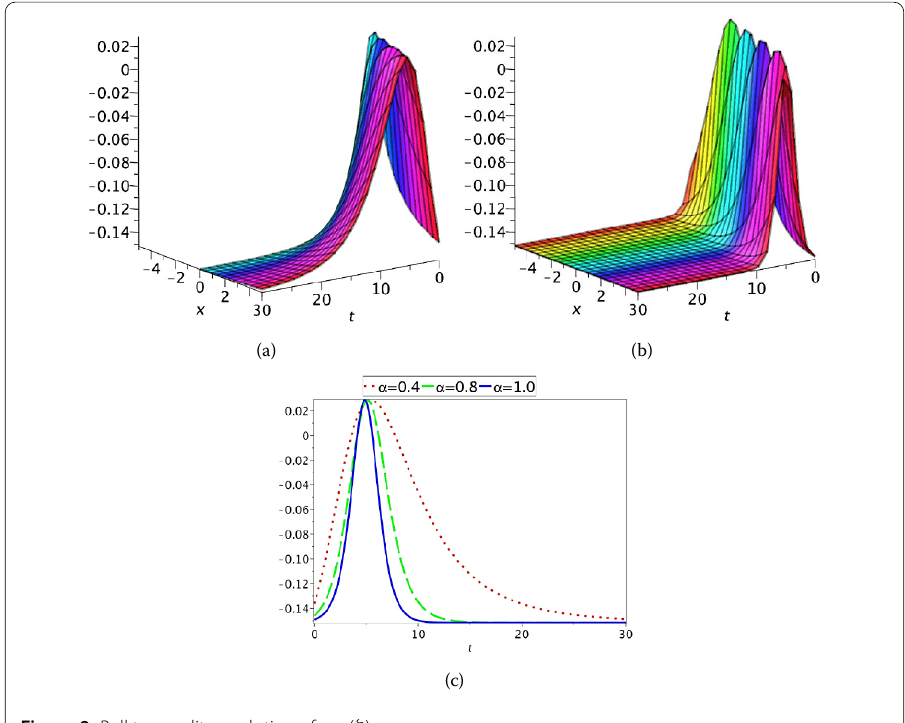
Figure 9 Bell type soliton solution of u 2,1 ( ξ